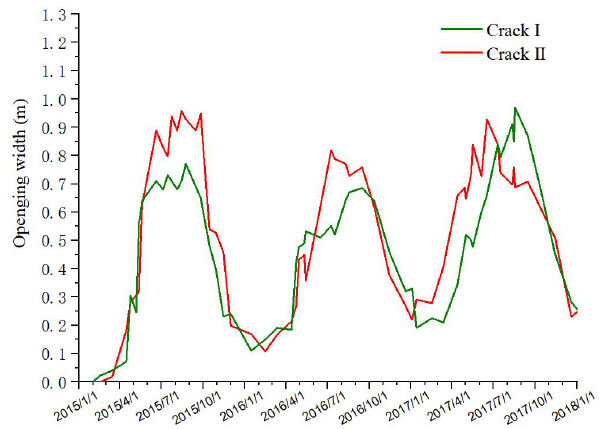
Figure 7. Plots of the absolute opening widths of cracks I and